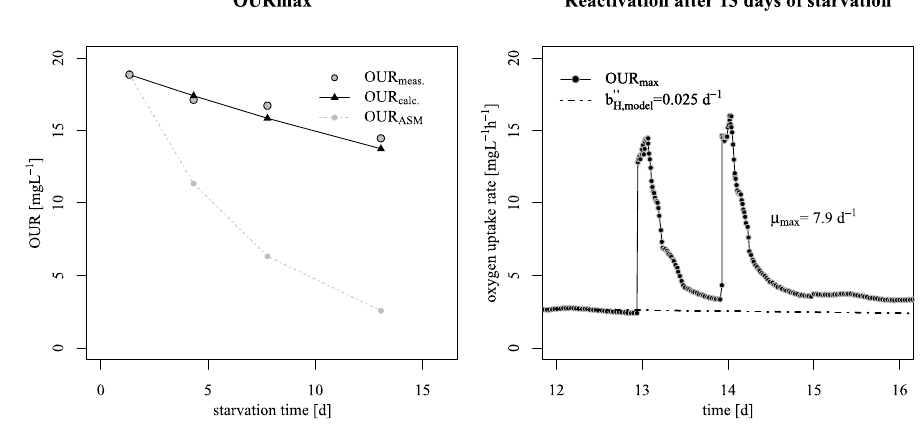
Figure 10. Reactivity of microorganism after starvation.